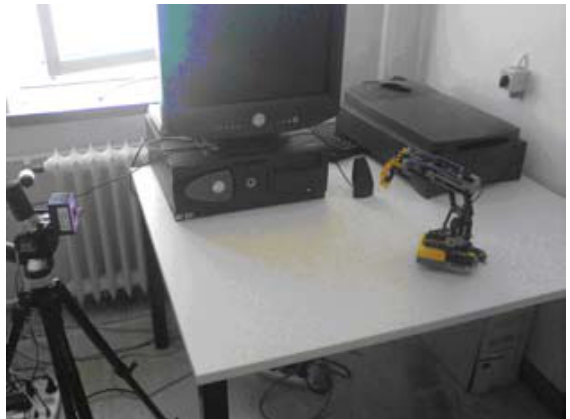
Fig. 3. Experimental setup